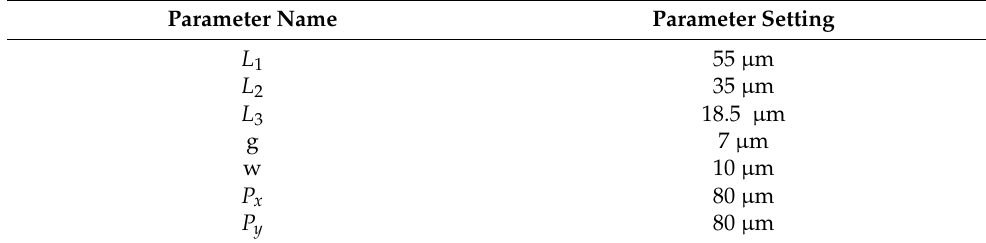
Figure 1. ( a ) Unit structure of the square ASR sensor; ( b ) Simulated transmission spectrum of the sensor. Table 1. Summary of geometric parameters of the ASR sensors.